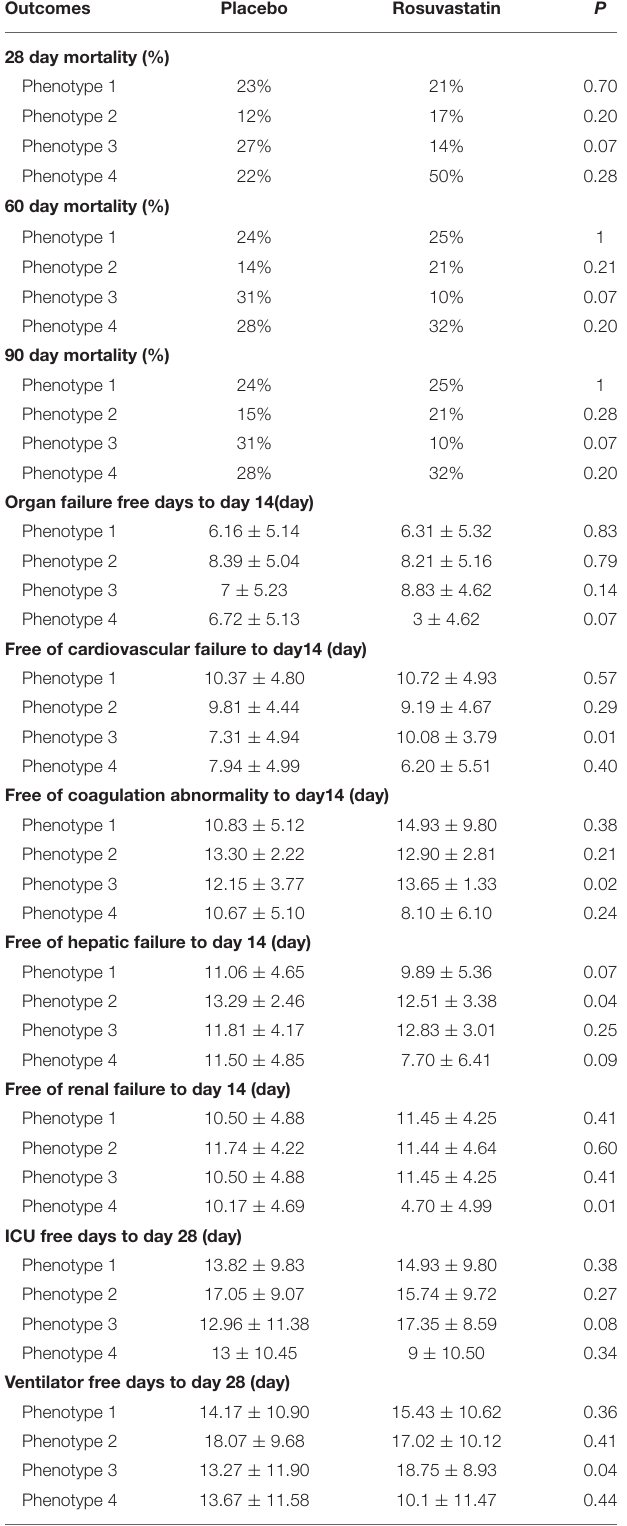
TABLE 1 | Outcomes in different